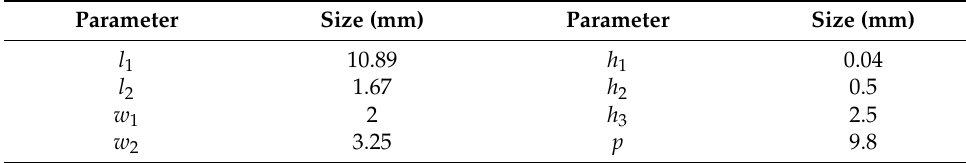
Table 2. Parameters of the APCM unit cell.